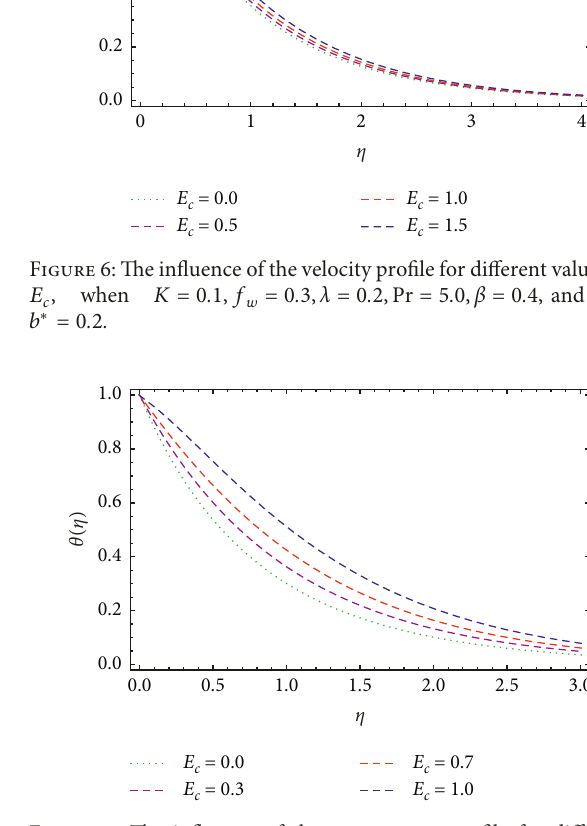
Figure 7: The influence of the temperature profile for different values of E c , when K � 0 . 1 ,f w � 0 . 3 , λ � 0 . 2 , Pr � 5 . 0 , β � 0 . 4 , and a ∗ � b ∗ � 0 . 2 .